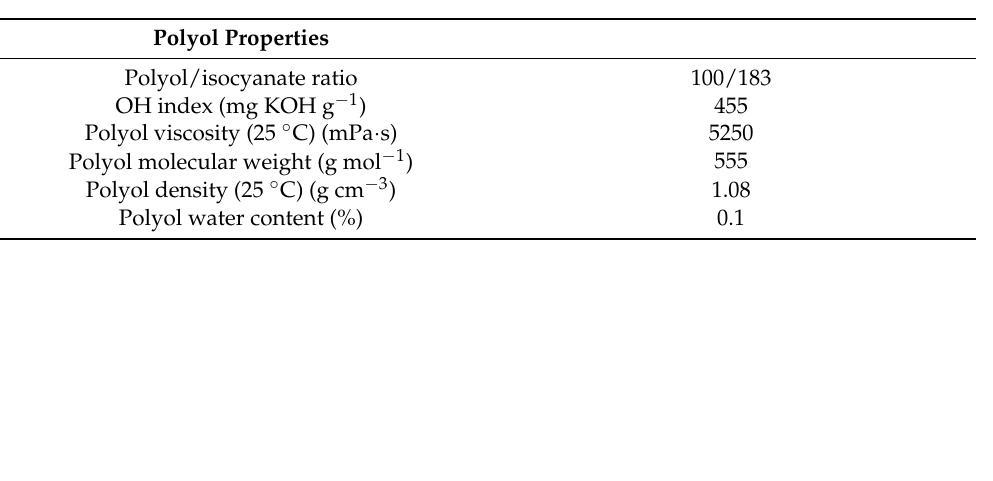
Table 1. Properties of the polyol used in this